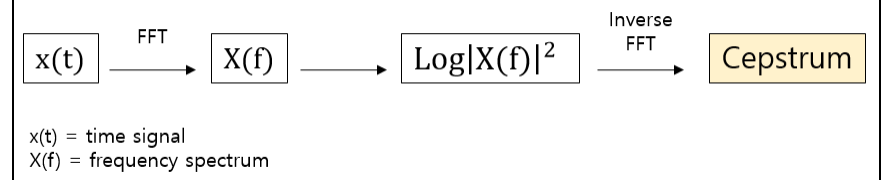
Figure 3. Cepstrum transformation process.